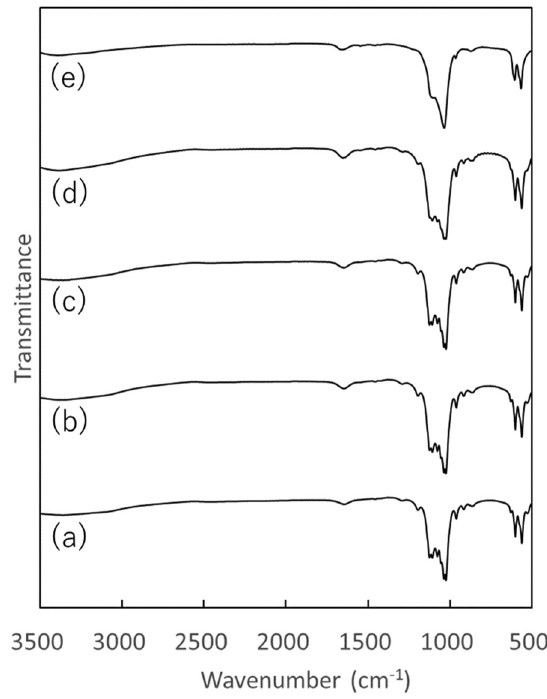
Fig. 2 FT-IR spectra of calcium phosphates with and without F – ion added during any protamine adsoprtion: a OCP, b OCP-P, c OCP- F10P, d OCP-F100P, and e